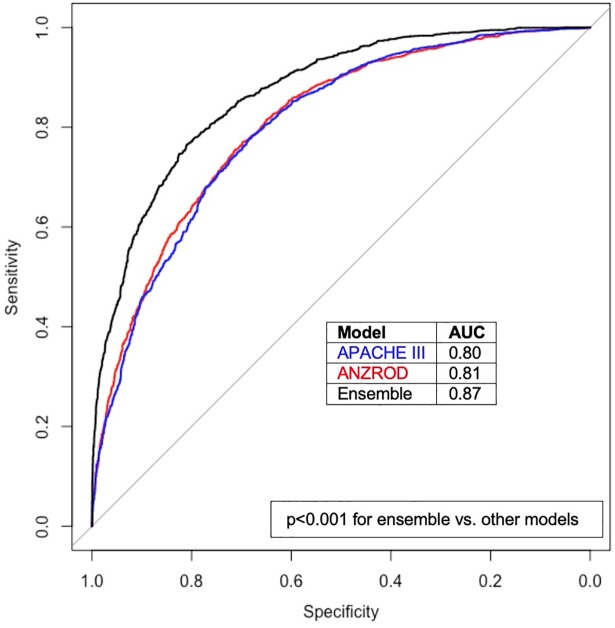
Receiver operating characteristic curves for existing prediction models and the ensemble ML model.ANZROD, red; APACHE III, blue; ensemble ML model, black. p-Value for comparison represents DeLong test. ANZROD, Australian and New Zealand Risk of Death; AUC, area under the curve; ML, machine learning.